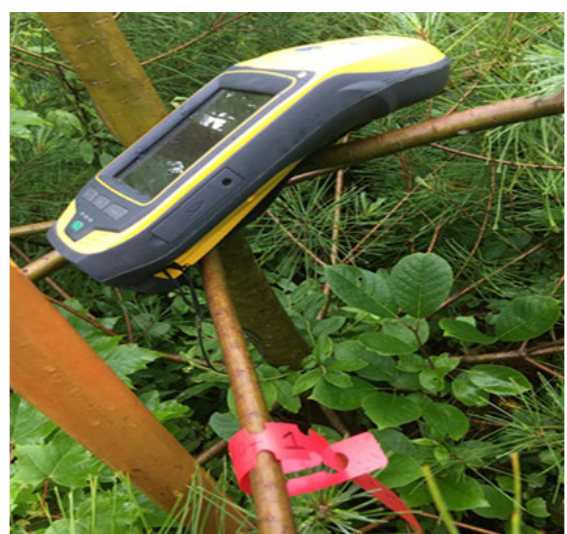
Figure 3: Trimble Geo XH 3000 global positioning system (GPS) unit